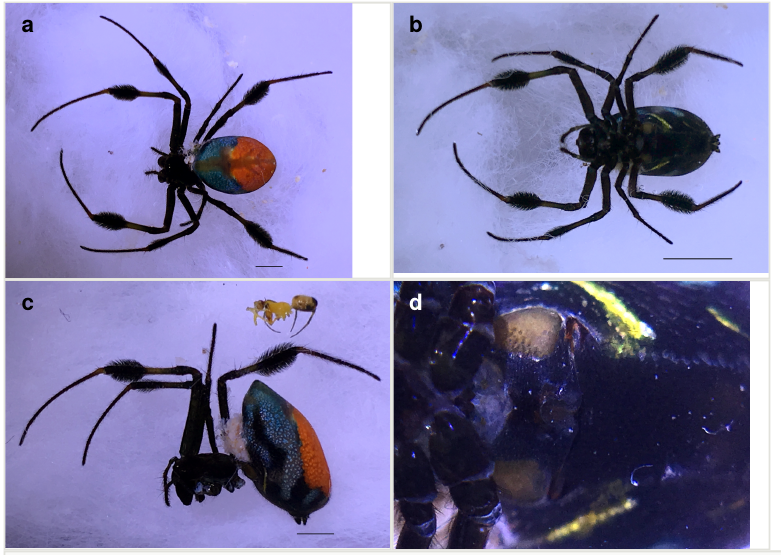
Figure 6. Female Opadometa sarawakensis Dzulhelmi & Suriyanti, 2015 (DGFCW2018022402), somatic morphology. a : Female, dorsal view. Scale bar 2 mm. b : Female, ventral view. Scale bar 2 mm. c : Female, lateral view, with male (DGFCW2018022300) to show sexual size dimorphism. Scale bar 2 mm. d : Epigynum, ventral view.